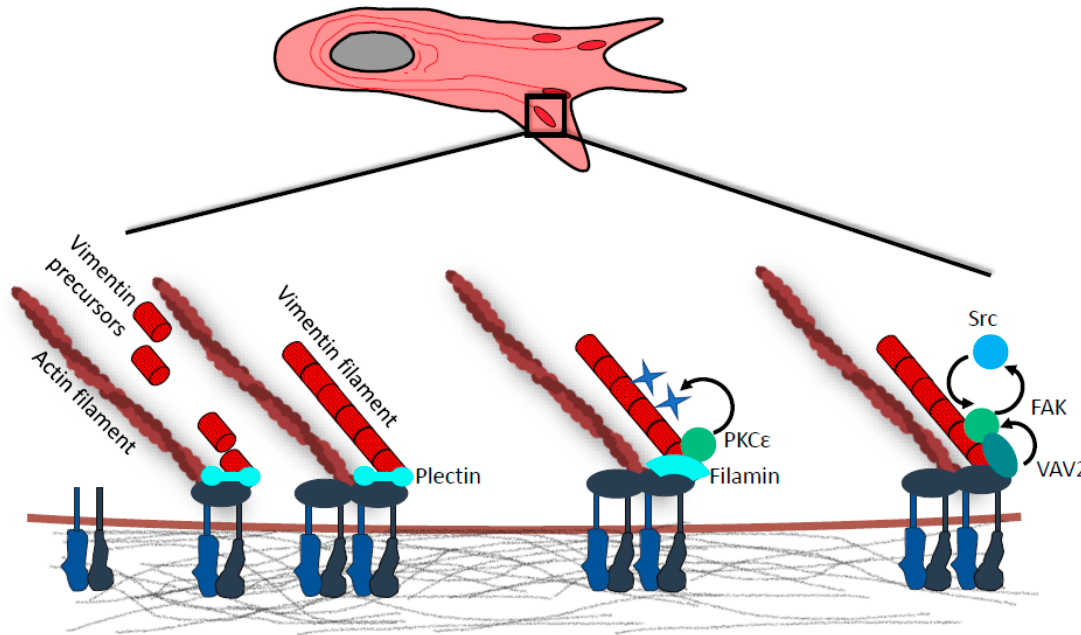
Figure 2. Vimentin in focal adhesions. Vimentin intermediate filaments (IF) precursors are captured at focal adhesions (FAs) via interaction with cytolinker protein plectin. Precursor docking is followed by end-to-end fusion of FA-immobilized and mobile vimentin intermediates with nascent vimentin filaments being incorporated into existing vimentin IF meshwork. Vimentin–FA association is